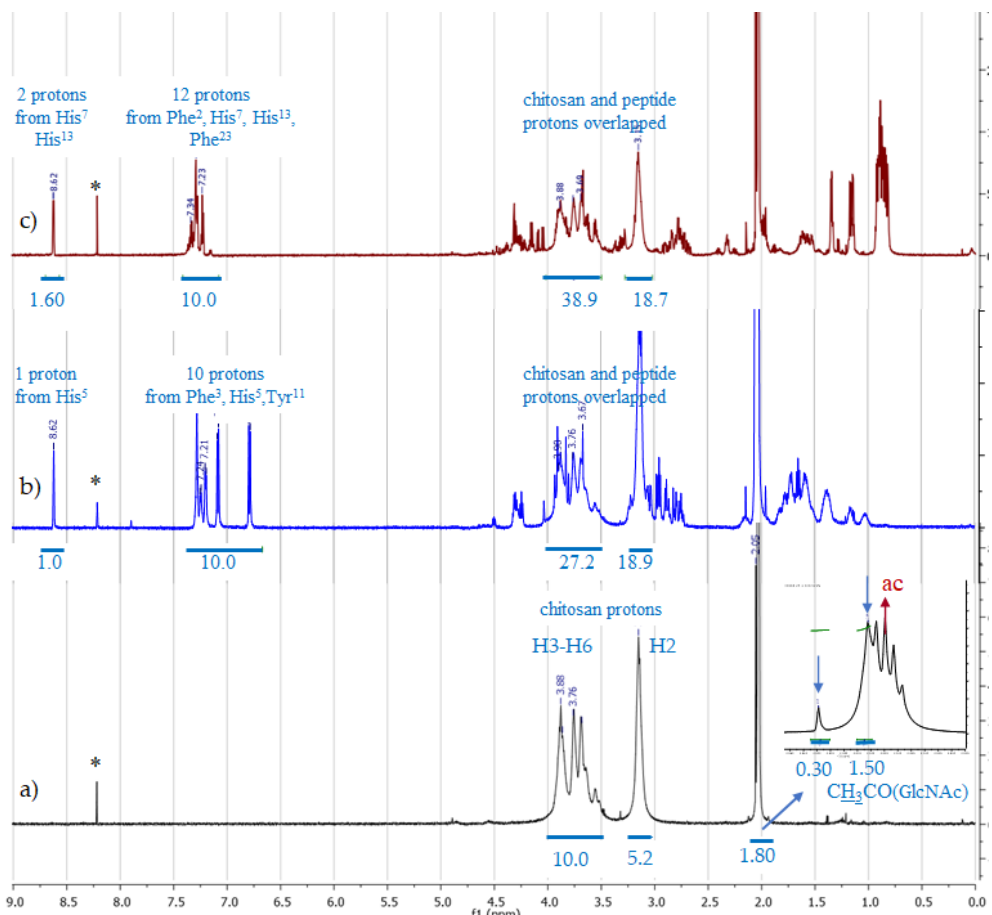
Figure 3. 1 H-NMR spectra of Chit ( a ), Chit-HVP ( b ), and Chit-GBMP1a ( c ) in deuterated acetic acid (ac) 2 M in D 2 O. The inset in (a) shows the expansion of the region 2.08 – 2.00 ppm, where the CH 3 CO group of GlcNAc shows two resonances, at 2.05 and 2.04 ppm (blue arrows). The 2.04 resonance overlaps the first line of the quintuplet due to CHD 2 COOD (ac). Blue lines and numbers under the peaks represent the integrated regions and the corresponding normalized integrals, respectively. = impurity.